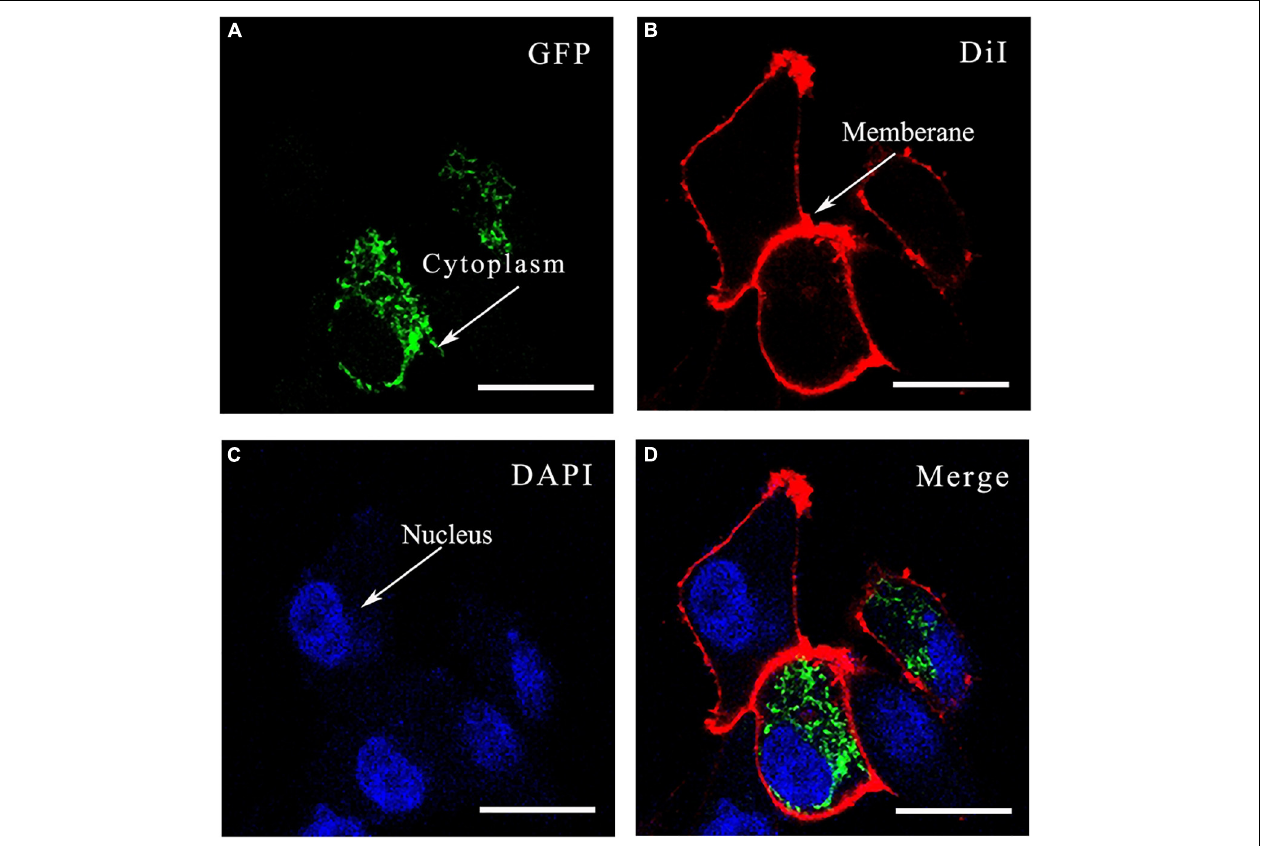
FIGURE 7 | The localization of Sj PRQFVRP-EGFP fusion protein in HEK293 cells. (A) GFP: Sj PRQFVRP-EGFP fusion protein was stained green; (B) DiI: cytomembranes of cells were stained red with DiI; (C) DAPI: nucleus of cells was stained blue with DAPI; (D) Merge: Sj PRQFVRP protein was mapped in the cytoplasm of HEK293 cells. Scale bars = 20 µ